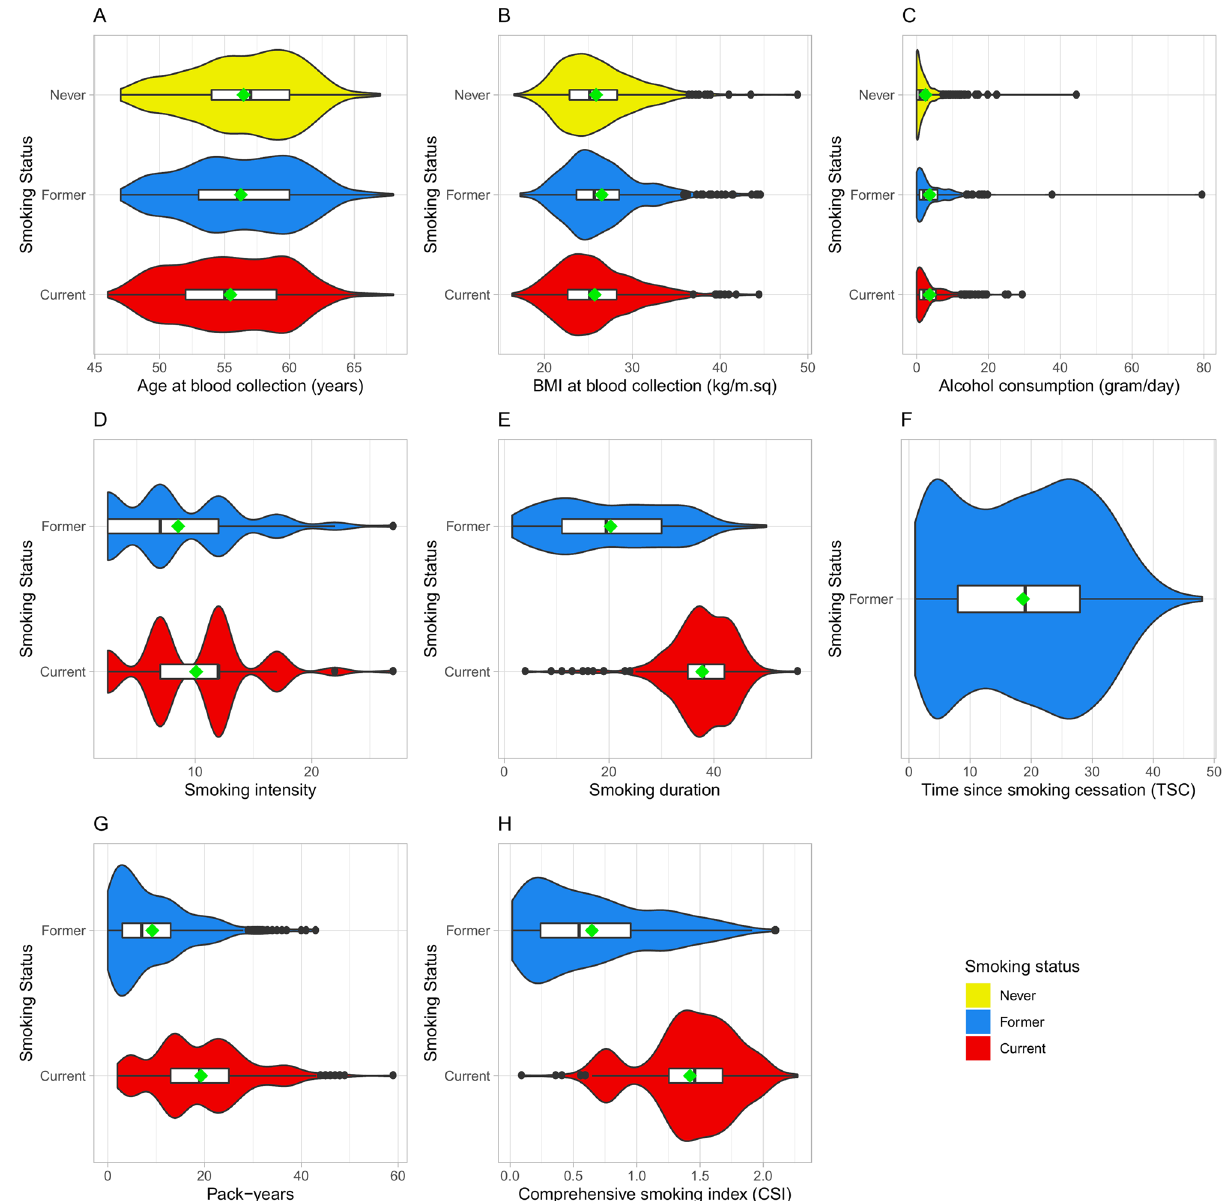
Figure 1. Descriptive statistics of study participants by smoking status for ( A ) age at blood collection, ( B ) body mass index (BMI) at blood collection, ( C ) alcohol consumption at baseline, ( D ) smoking intensity, ( E ) smoking duration, ( F ) time since smoking cessation (TSC), ( G ) pack-years, and ( H ) comprehensive smoking index (CSI) scores. Yellow, blue, and red coloured violin plots represent kernel density estimates for never, former, and current smokers, respectively. White boxes extend from the 25th to the 75th percentile, vertical bars inside the box represent the median, whiskers extend 1.5 times the length of the interquartile range right and left side of the 75th and 25th percentiles respectively, and outliers are represented as black dots. The green diamond shaped dot represents the respective (Supplementary Table S4) and 839 in the CS-vs-FS comparison (Supplementary Table S5). Similarly, the CS- vs-NS and CS-vs-FS comparisons had 776 and 652 overlapping DEGs in the minimally- and fully-adjusted models, respectively. In the fully-adjusted models, there were 230 up-regulated and 422 down-regulated genes that overlapped between the CS-vs-NS and CS-vs-FS comparison and displayed the same direction of effects. The top-ranked gene (i.e., the gene with the lowest FDR adjusted p -values) in all comparisons was LRRN3 (Sup- plementary Fig. S2). Receiver operating characteristics (ROC) curve analyses showed that expression levels of LRRN3 , as measured by the Illumina arrays, could strongly distinguish CS from NS and moderately distin- guish FS (with ≤ 10 years TSC) from NS (Supplementary Fig. S3). Moreover, in a subset of our dataset, LRRN3 expression showed similar discriminative power as DNA methylation at the AHRR CpG site (cg05575921), which is a known marker for smoking exposure 19 . There were no DEGs in the FS-vs-NS comparison in either